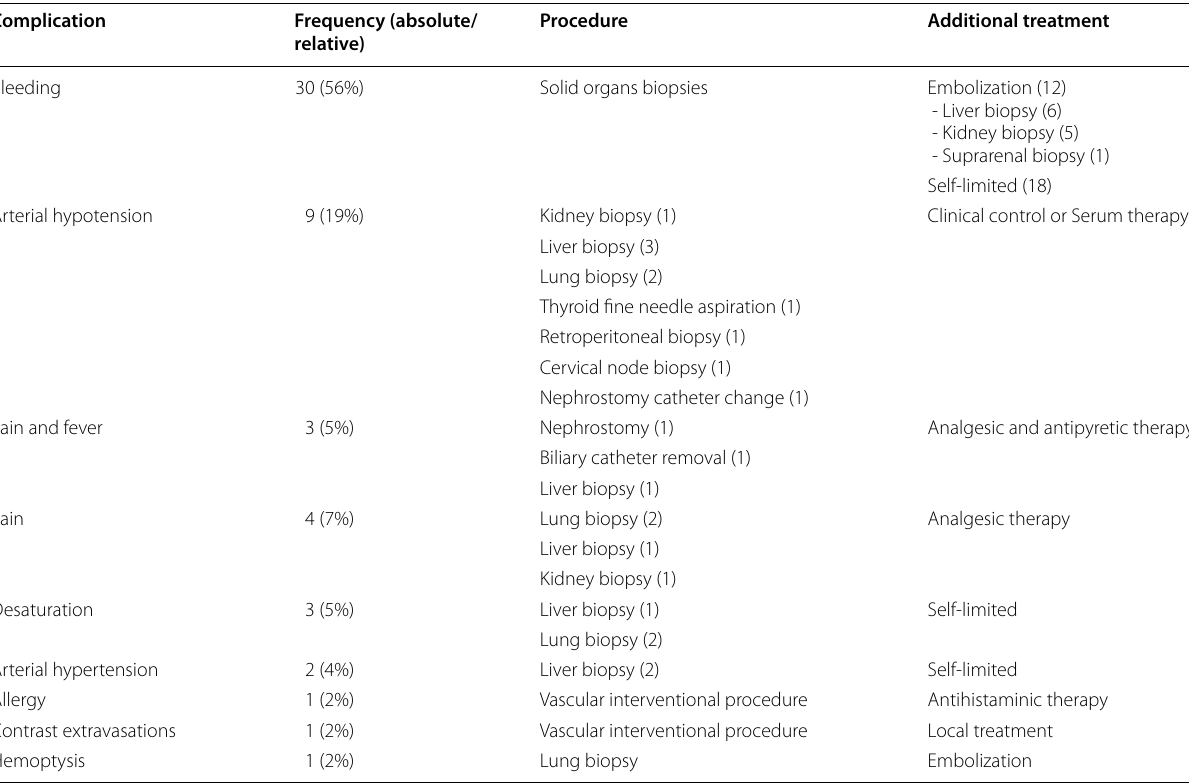
Table 4 Post‑procedure complications, its frequency and treatment reported during the follow‑up period at the Radiology Day